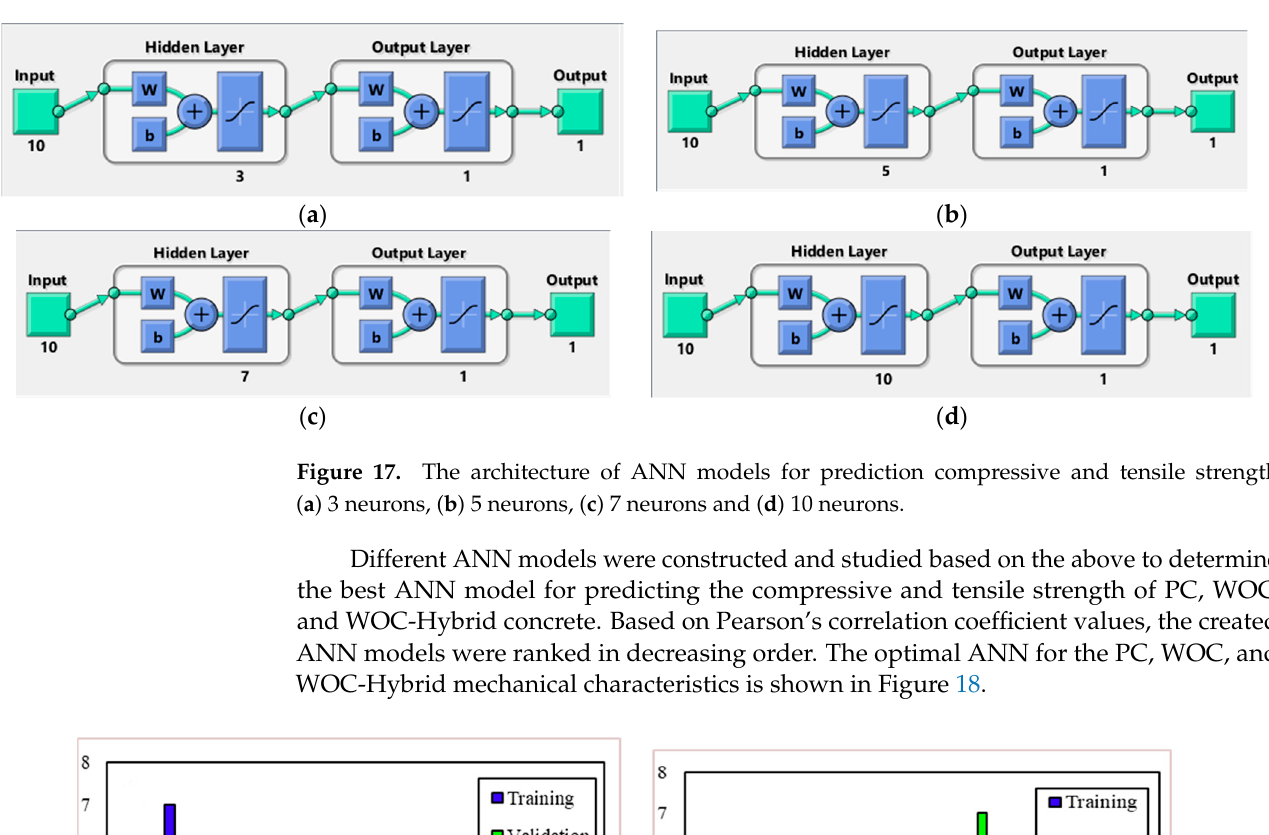
Figure 16. ( a ) Single hidden layer neural network architecture, ( b ) flowchart of the artificial neural network training process.